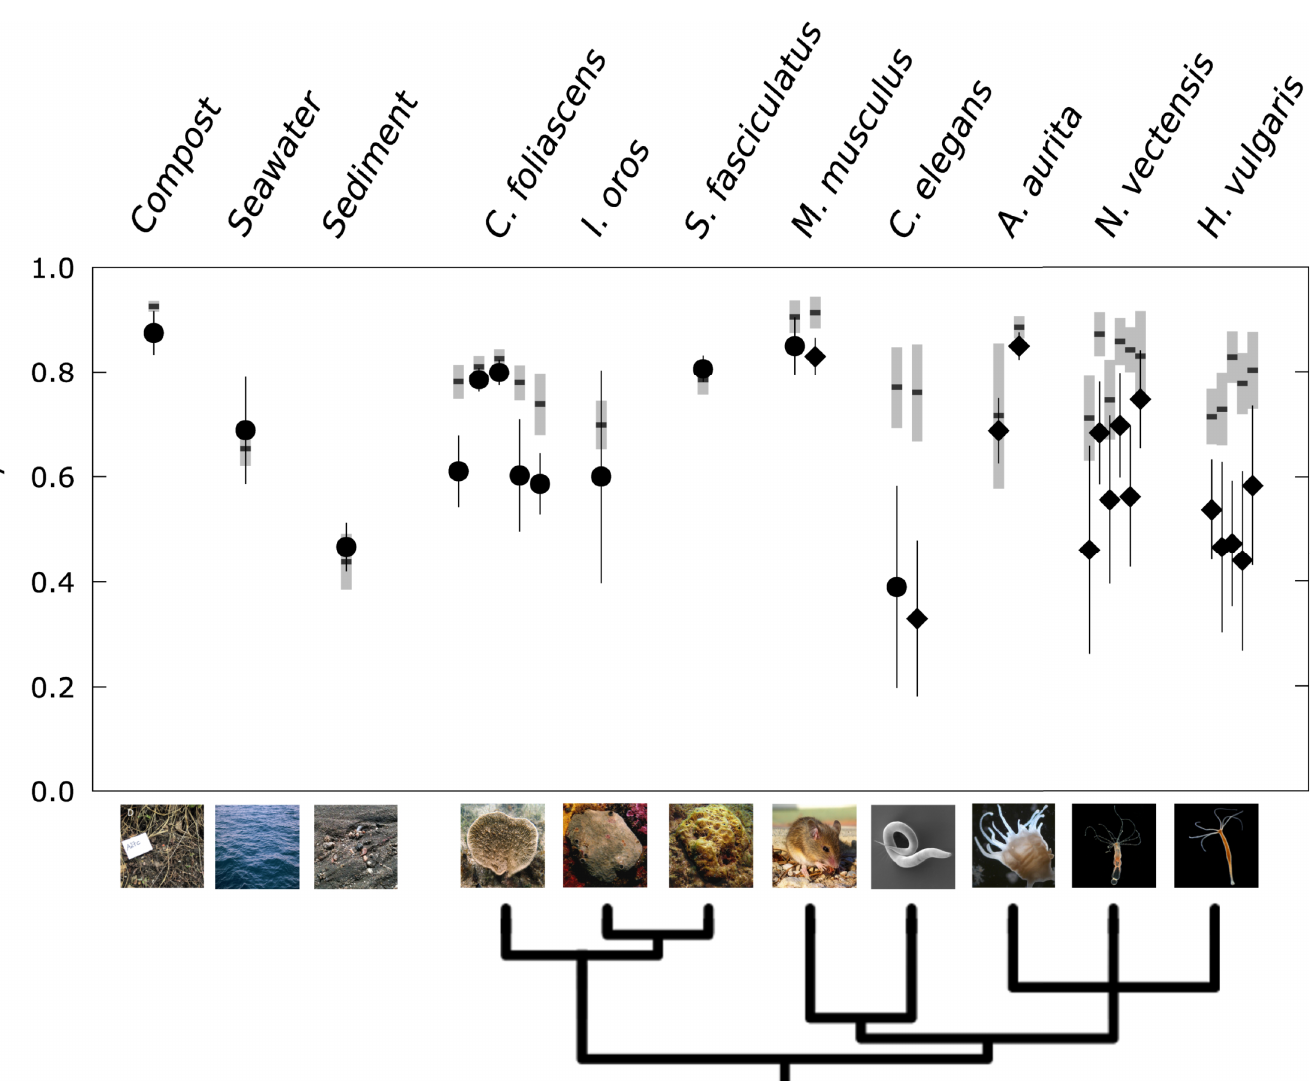
Fig 3. Goodness of fit of the neutral expectation to a range of host-associated and environmental communities. Circles denote natural populations and diamonds denote laboratory populations; error bars indicate 95% bootstrap confidence intervals. The gray bars indicate the 95% bootstrap confidence intervals around the expected goodness of fit (horizontal black line) to a neutral simulation, providing a comparison to a completely neutral community with the same sample size and diversity. The data for C . foliascens are from several different natural populations, while the data for H . vulgaris and N . vectensis are from different time points. The spread of points along the x-axis is added to increase visibility. The data used to generate this figure are available in S7 Data. Phylogeny were generated with phyloT based on NCBI taxonomy. Sponge photographs courtesy of Susanna Lo´pez-Legentil (UNC Wilmington) and Mari-Carmen Pineda (AIMS). AIMS, Australian Institute of Marine Science; NCBI, National Center for Biotechnology Information; UNC, University of North Carolina.